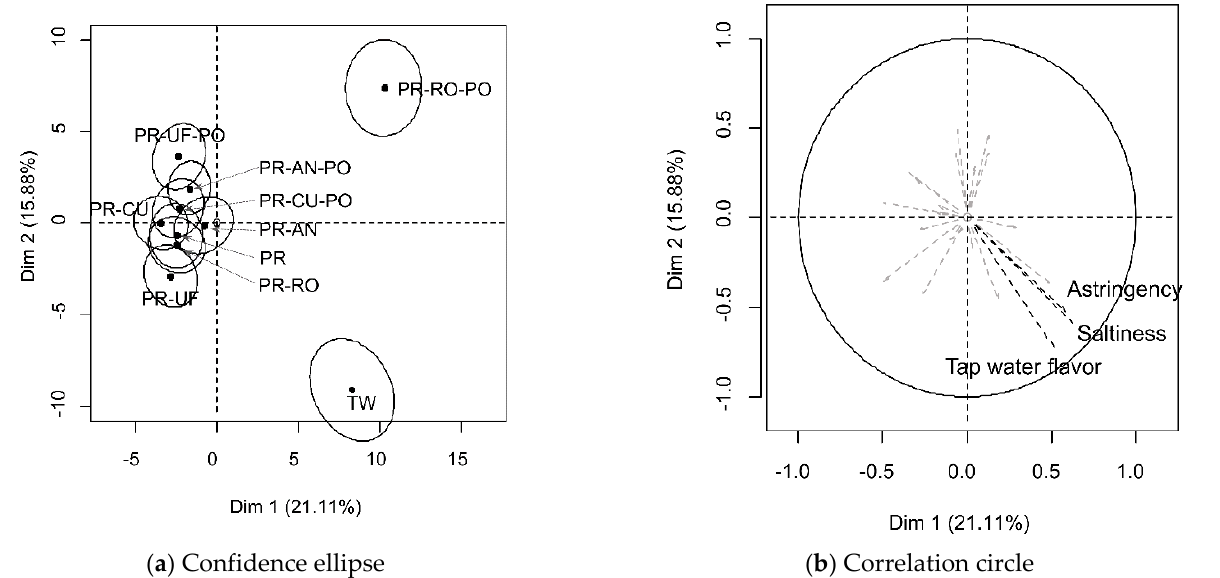
Figure 3. Representation of 10 purified water samples: ( a ) in the first two dimensions of the multiple factor analysis performed on the data from polarized sensory positioning; and ( b ) the corresponding sensory descriptors used as supple- mentary variables. Sample codes refer to Figure 1.